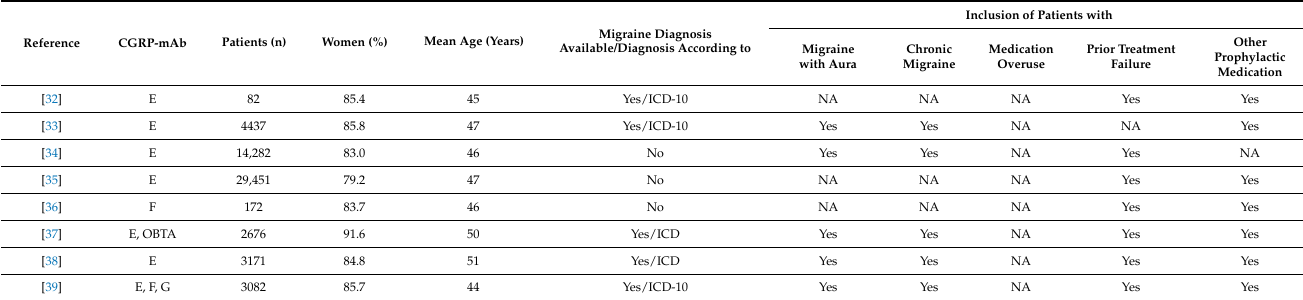
Table 1. Pharmacoepidemiologic